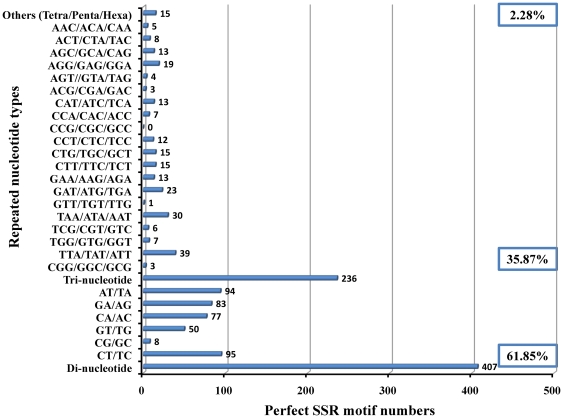
Distribution of simple sequence repeat (SSR) nucleotide classes among different nucleotide types found in M. rosenbergii sequences.Both contig and singleton sequences are used to predict the SSR loci.